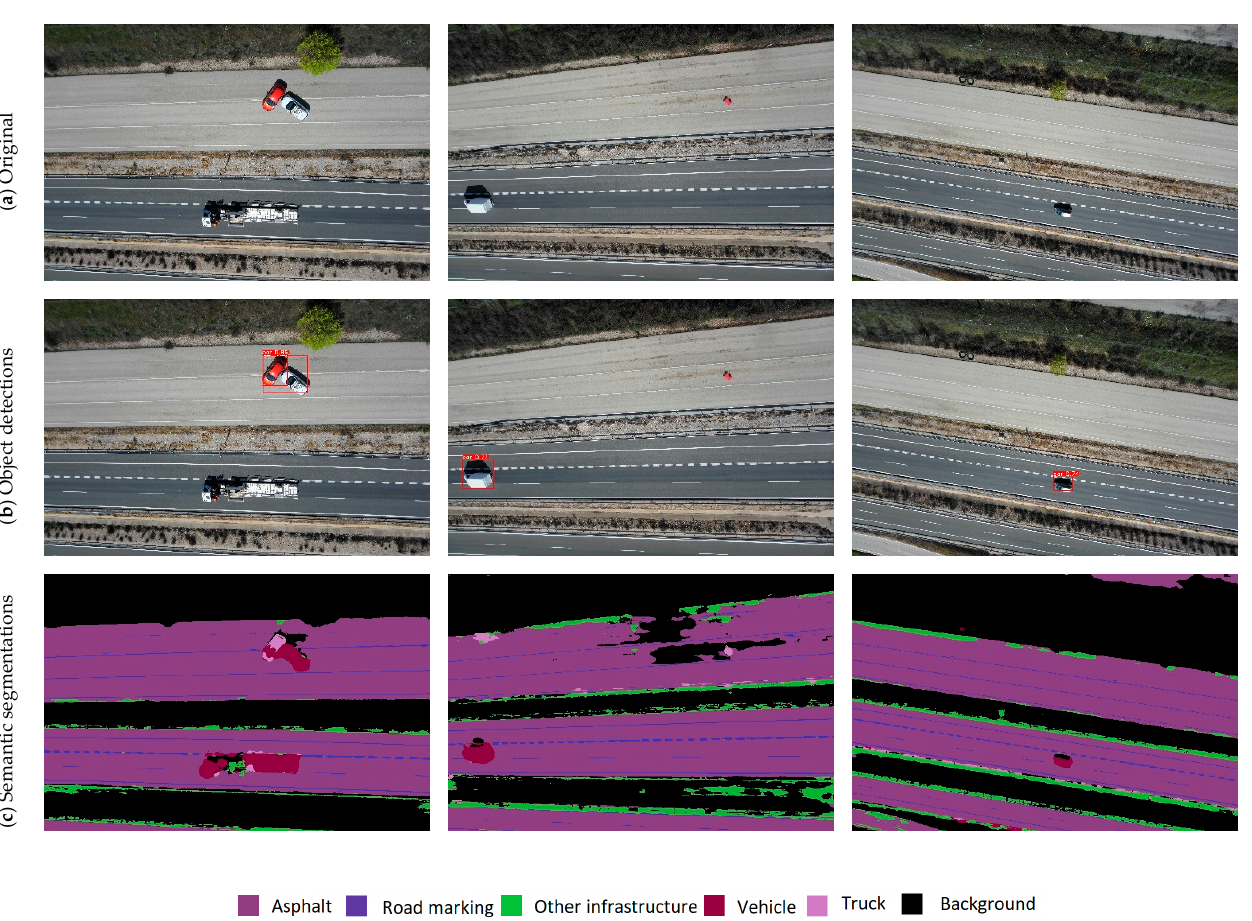
Figure 5. ( a ) Images from the trial site showing two lanes of the main A-2 highway ( bottom ) and the service road ( top ) where a traffic incident and foreign object scenario were simulated. ( b ) Results from the vehicle detector module. ( c ) Results from the scene segmentation module.